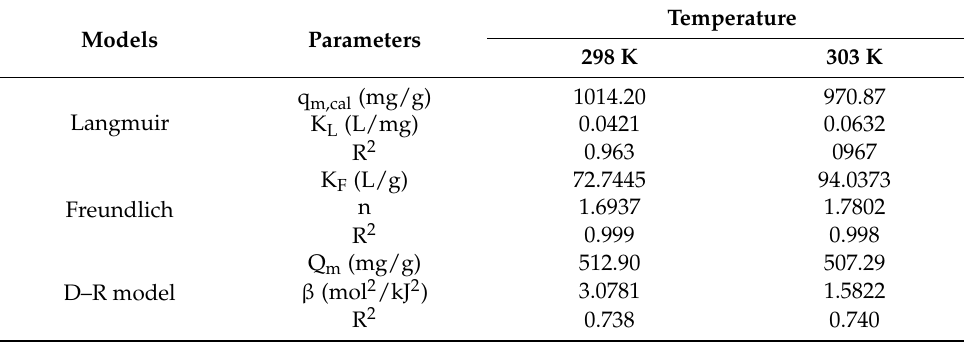
Table 3. Isothermal model parameters of SL adsorption by